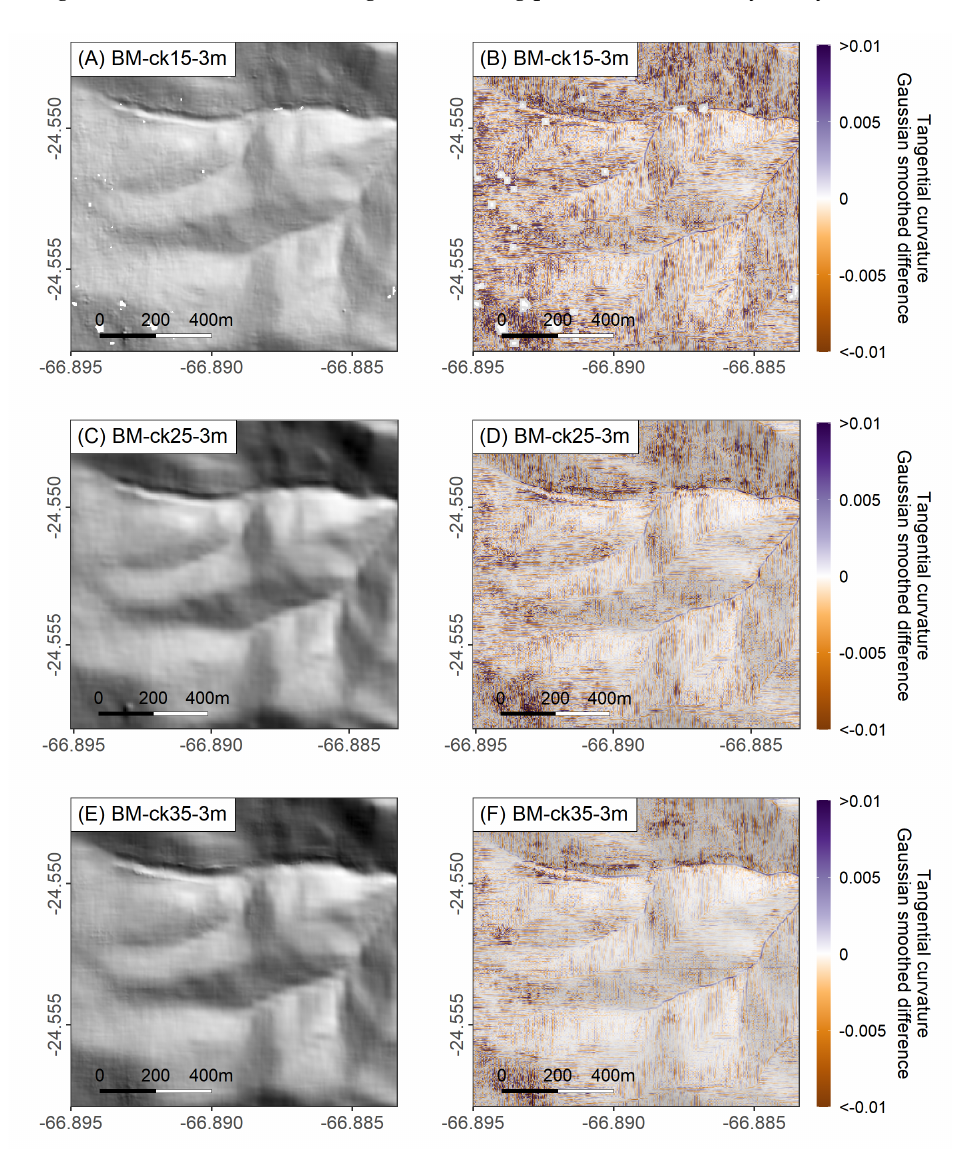
Figure 12. Difference between tangential curvature calculated in a 3 × 3 pixel window and a Gaussian- smoothed version of this curvature map for the BM DEMs. Same area as is shown in Figure 3 (see Figure 2A for location in study area); ( A ) hillshade of the BM DEM with a CK of 15 × 15 pixels; ( B ) curvature difference map for this DEM. Larger differences occur in areas with more spiky DEM curvature; ( C – F ) similar pairwise (hillshade and curvature difference) results for the CK 25 × 25 and 35 × 35 pixel BM